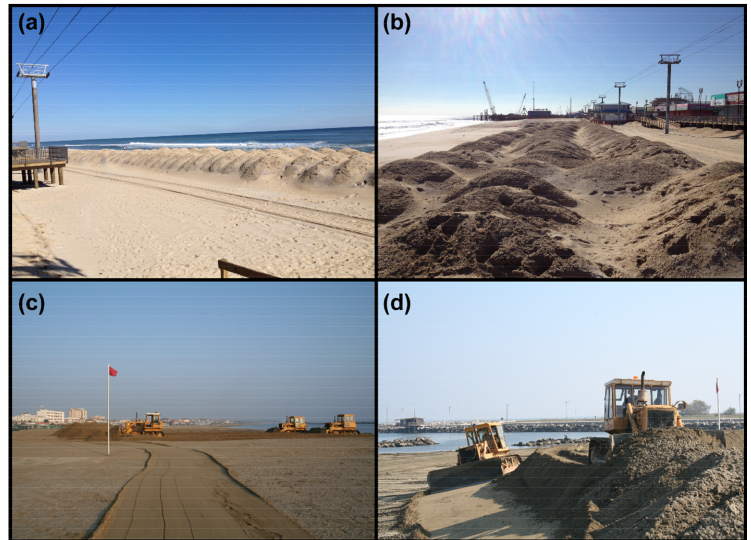
Figure 2. Examples of artificial dunes: ( a , b ), Seaside Park (New Jersey, USA), 18 October 2013 (Photo: Edoardo Grottoli); early ( c ) and final ( d ) building stages of the scraped dune at Porto Garibaldi (Comacchio, Italy), 16 October 2017 (Photo: Enrico